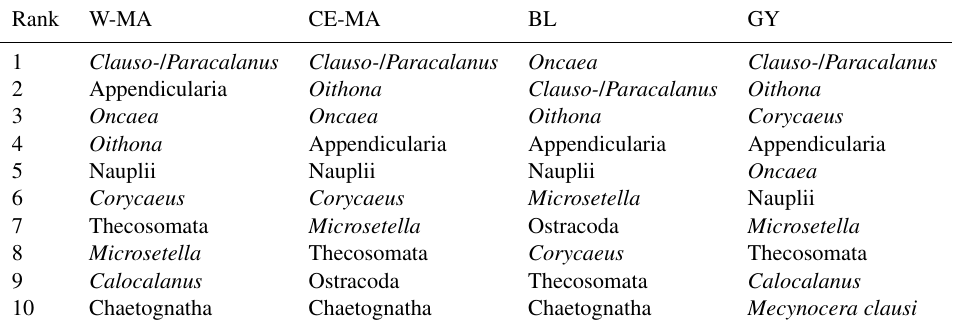
Table 5. Top 10 taxa in frequency abundance for the four regions (W-MA: western Melanesian archipelago; CE-MA: central and eastern Melanesian archipelago; BL: station B, blooming conditions; GY: subtropical gyre).